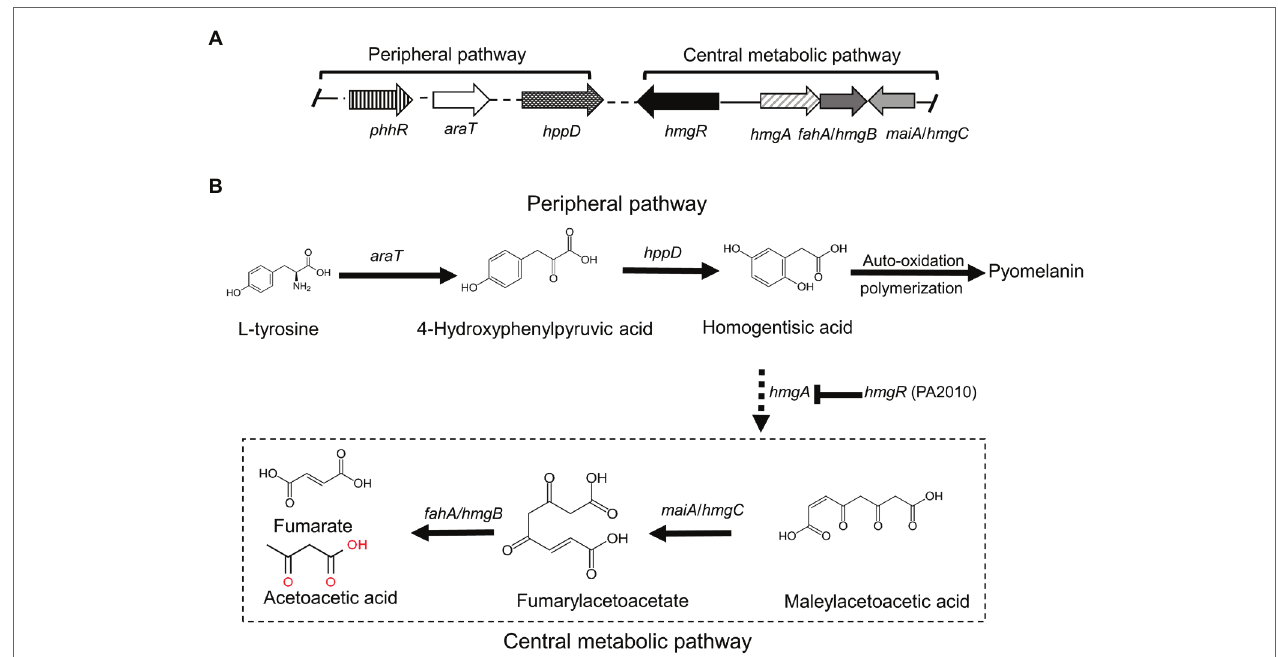
FIGURE 4 | Proposed pathway and gene clusters of pyomelanin biosynthesis in strain GR-TSA-9 T (modified from Schmaler-Ripcke et al., 2009). (A) Gene cluster organization and expression of pyomelanin biosynthesis, homogentisate, and central pathways. (B) Pyomelanin biosynthesis and regulation pathway. The enzymes involved are as follows: phhR (JIP62_13420; JIP62_13620; JIP62_02890; and JIP62_0119), sigma-54-dependent Fis family transcriptional regulator; araT (JIP62_09170), aromatic amino acid aminotransferase (EC 2.6.1.57); hppD (JIP62_07560), hydroxyphenylpyruvate dioxygenase (EC 1.13.11.27); hmgR (JIP62_11565; JIP62_04630; and JIP62_01885), TetR family member transcriptional regulator; hmgA (JIP62_08245), homogentisate dioxygenase; hmgC / maiA (JIP62_08415), maleylacetoacetate isomerase; and fahA / hmgB (JIP62_RS07590; JIP62_RS08410; and JIP62_RS01250), fumarylacetoacetate